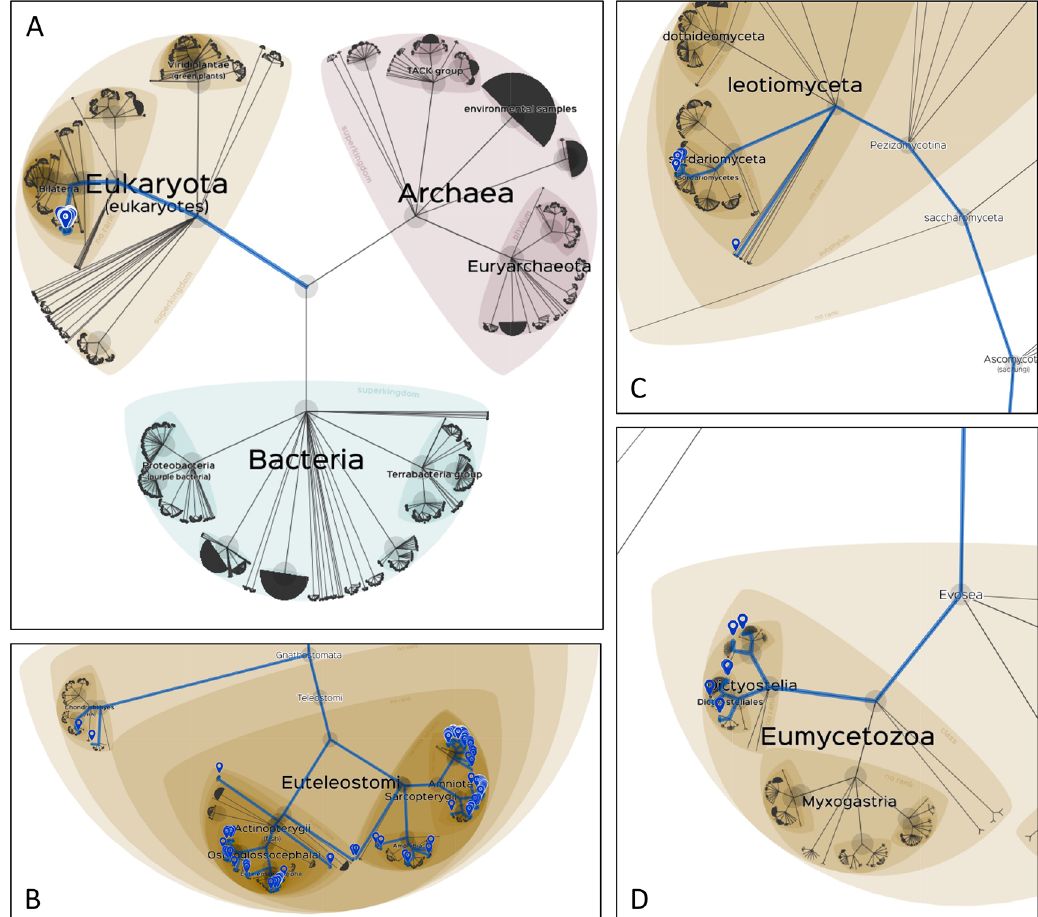
Figure 5. Taxonomic distribution of sequence alignment hits for selected genes, across the URP proteome dataset. A)abroadviewofthetreeoflife,visualisedbyLifemap(deVienne,2016).ALG13hitsarehighlightedinblue. B) A zoomed in view of all ALG13 hits. C) SIX3 hits that belong to the Ascomycota phylum and are not found for any other gene of the dataset. D) RP9 hits that correspond to the Dictyostelia clade and are not found for any other gene of the